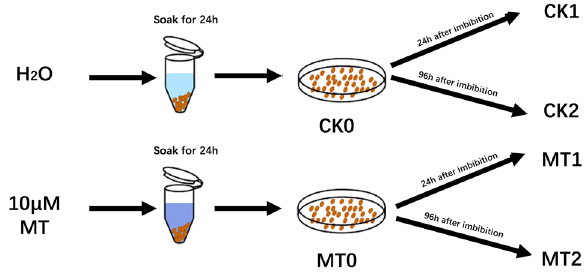
Figure 2. schematic of seed treatment. The seeds were immersed in water and 10 μm MT solutions for 24 h, and then placed on plastic petri dishes. At 24 and 96 h after imbibition, the water treated seeds were named CK1 and CK2, and the melatonin treated seeds were named MT1 and MT2.